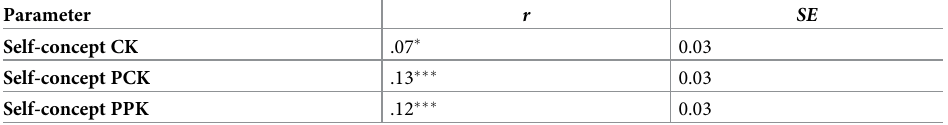
Table 3. Results of the correlation analysis for relationships between enthusiasm for teaching and indicated dimensions of academic self-concept. Parameter